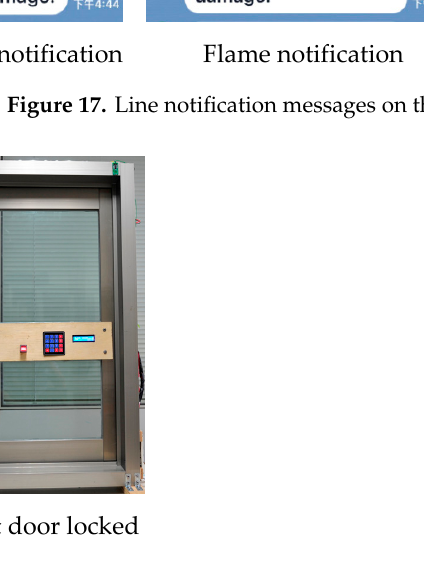
Figure 18. Door being automatically unlocked.